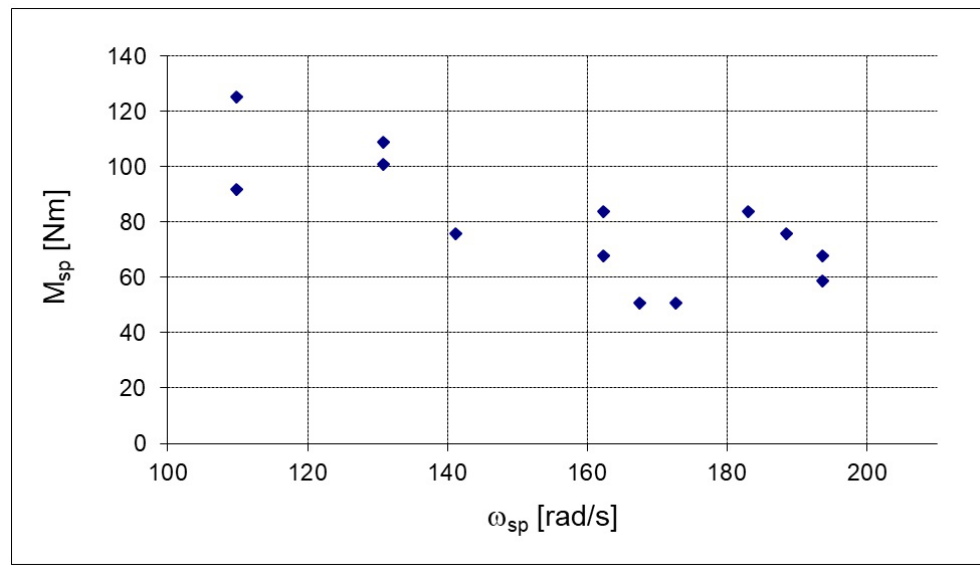
Figure 13. Feasible combustion engine duty points for load I and gas hydraulic accumulator capacity V a = 0.005 [m 3 ].